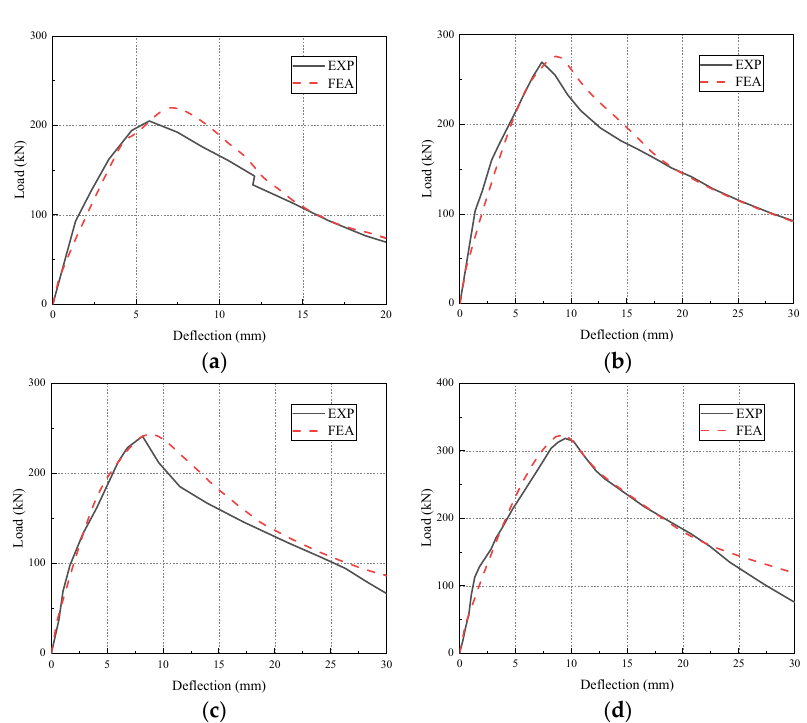
Figure 14. Comparison of load–deflection curves between test by Bae [50] and simulation: ( a ) 120 ‐ 5db ‐ V1.5; ( b ) 120 ‐ 10db ‐ V1.5; ( c ) 180 ‐ 10db ‐ V1; ( d ) 180 ‐ 10db ‐ V2.